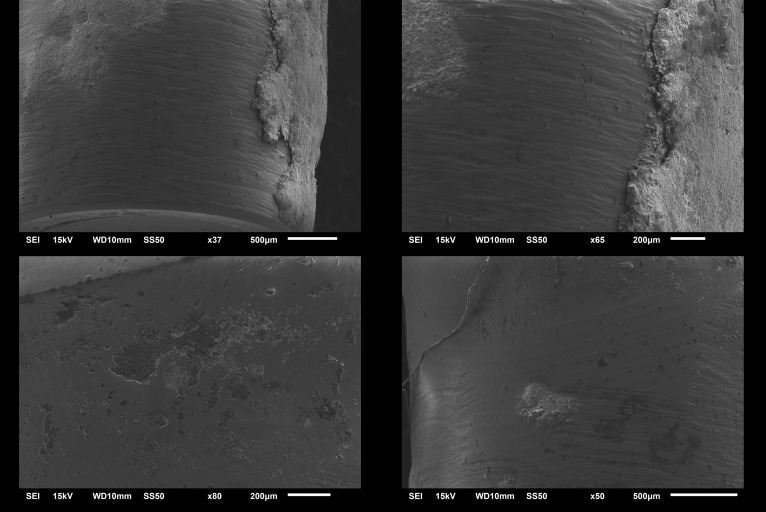
SEM images zirconium abutment without irradiation and after irradiation at 200μm and 500μm scale.Note residual cement on intact abutment surface. Top left (500μm) and right (200μm) demonstrates area of zirconia abutment surface with residual cement. Bottom left (200μm) and right (500μm) demonstrate the area of zirconia abutment without residual cement. Note normal smooth surface without any noticeable damage of zirconia.